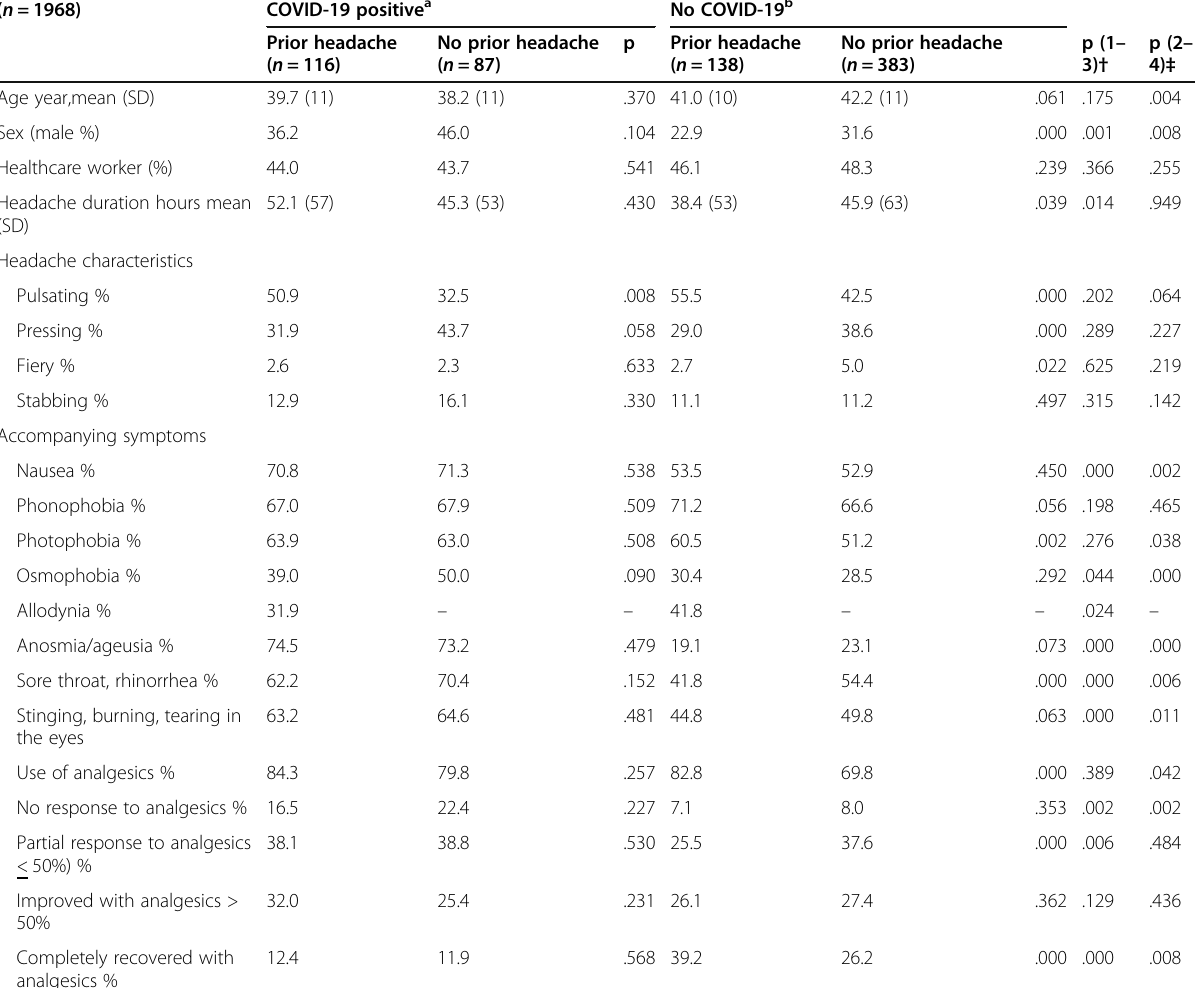
Table 1 Demographic features of participants and characteristics of headache experienced during the pandemic period ( n =